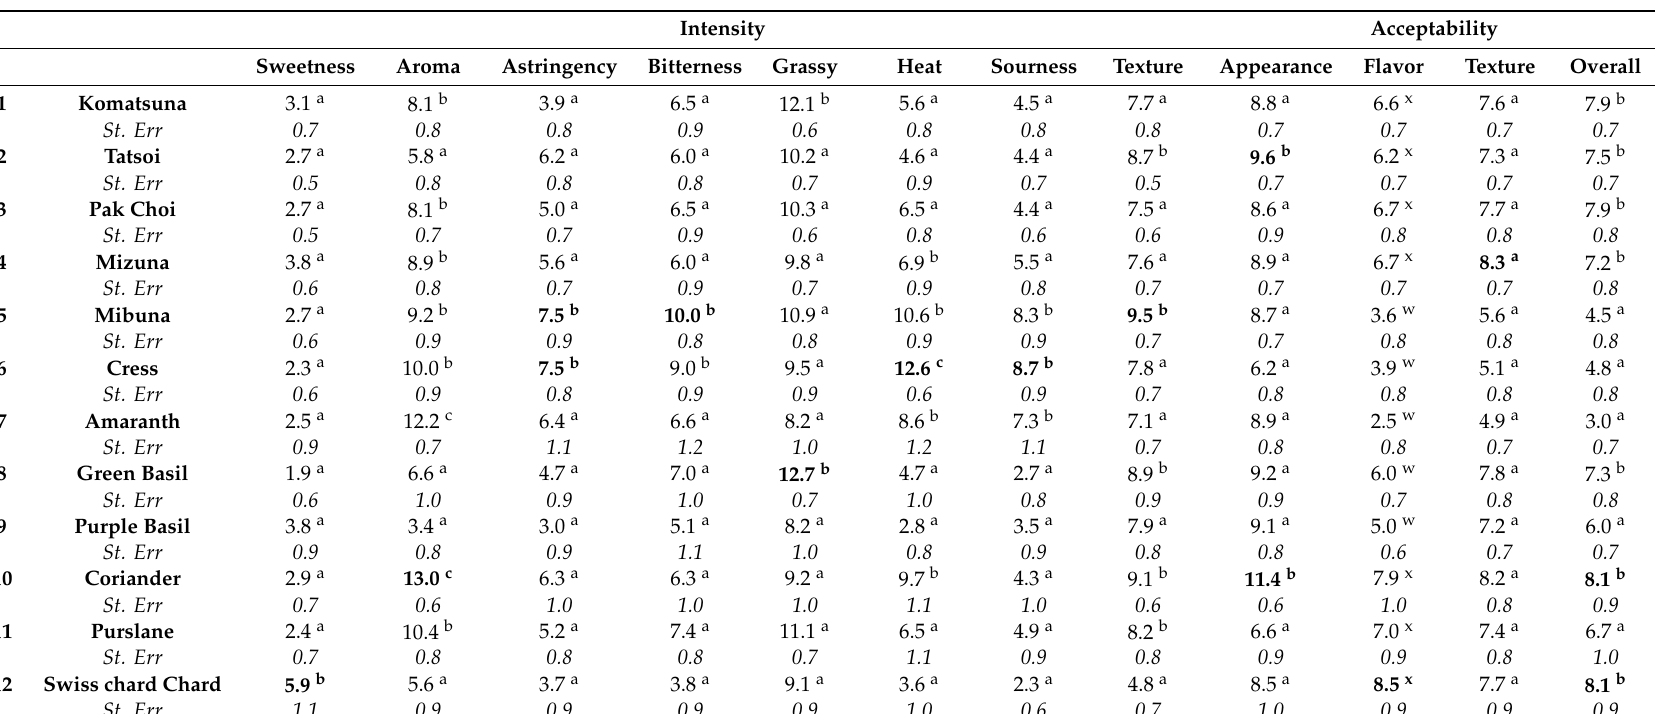
Table 2. Sensory attributes and acceptability items collected during the consumer test; mean and standard error of the nine sensory attributes and four acceptability items for the 12 microgreens